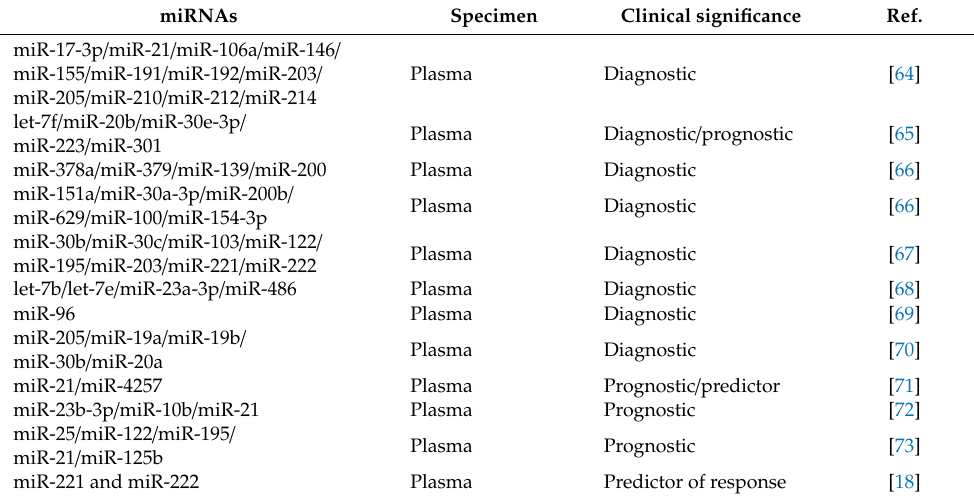
Table 3. Exosomal miRNAs studies in lung